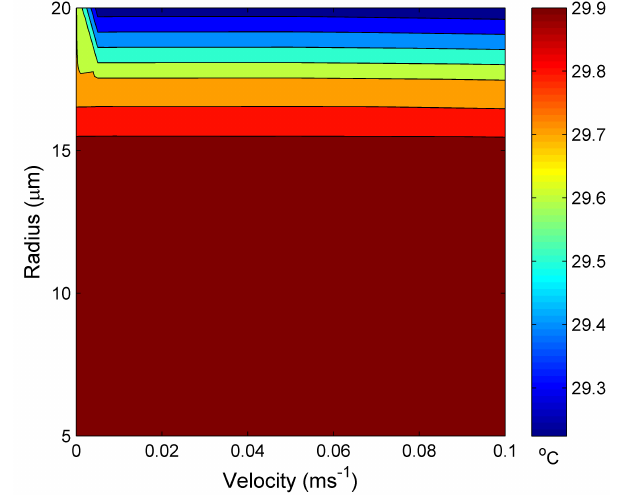
Figure 6. Calculated temperature at the steady state vs. the water hole radius and water input velocity at 30 ◦ C